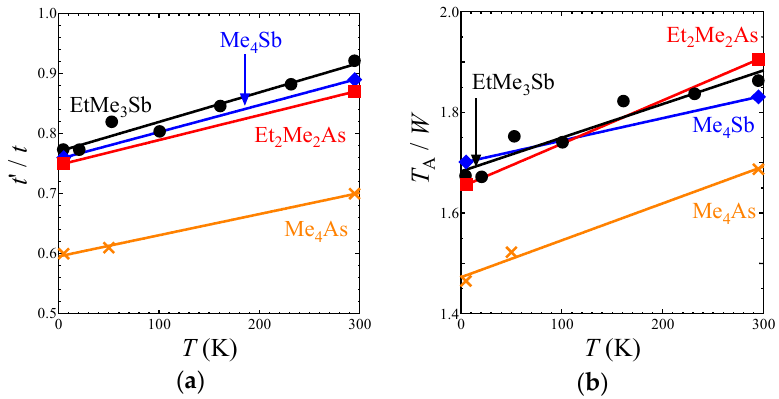
Figure 3. Temperature dependence of ( a ) t ′ / t and ( b ) T A / W in the Me 4 Sb, Me 4 As, Et 2 Me 2 As, and EtMe 3 Sb salts.